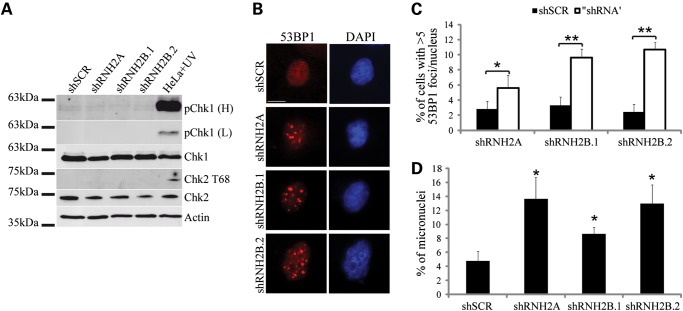
Depletion of RNase H2 induces DDR and causes genome instability. Total protein extract of silenced HeLa cells was blotted with indicated antibodies, HeLa irradiated with UV (20 J/m2) were used as control (pChk1, anti-Chk1 Ser317; L, low exposure; H, high exposure) (A). HeLa cells were immunostained with an anti-53BP1 antibody and DAPI to stain nuclear DNA (scale bar: 10 μm, magnification ×63) (B). The histograms indicate the percentage of cells that have at least five 53BP1 foci/nucleus. Error bars represent mean ± s.e.m.; n = 4 for shRNH2A and shRNH2B.1, n = 5 for shRNH2B.2; *P < 0.05, **P < 0.01 (t-test). (C) The histograms in (D) indicate the percentage of micronucleated cells. Error bars represent mean ± s.e.m.; n = 4; *P < 0.02 (t-test).